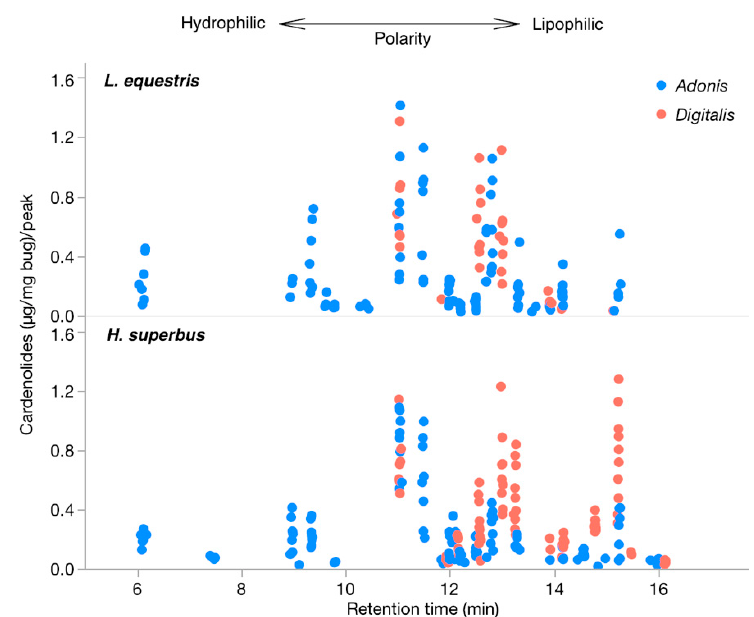
Figure 5. Concentrations of the sequestered individual cardenolides and retention times based on HPLC analysis. Each datapoint represents an individual cardenolide sequestered by a specimen of L. equestris (n = 8 per treatment) ( top ) and H. superbus (n = 8–10 per treatment) ( bottom ) raised on the seeds of either Adonis vernalis (blue) or Digitalis purpurea (red). Polar cardenolides (hydrophilic) have shorter retention times and apolar cardenolides (lipophilic) have longer retention times.